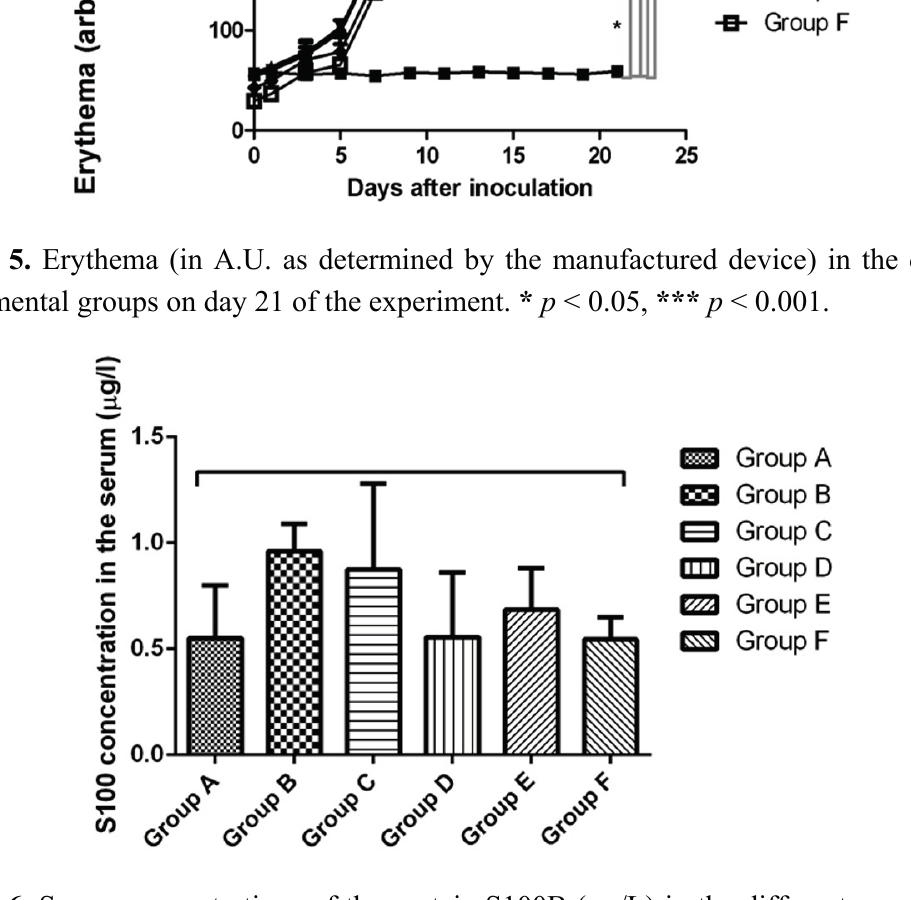
Figure 6. Serum concentrations of the protein S100B (µg/L) in the different experimental groups on day 21 of the